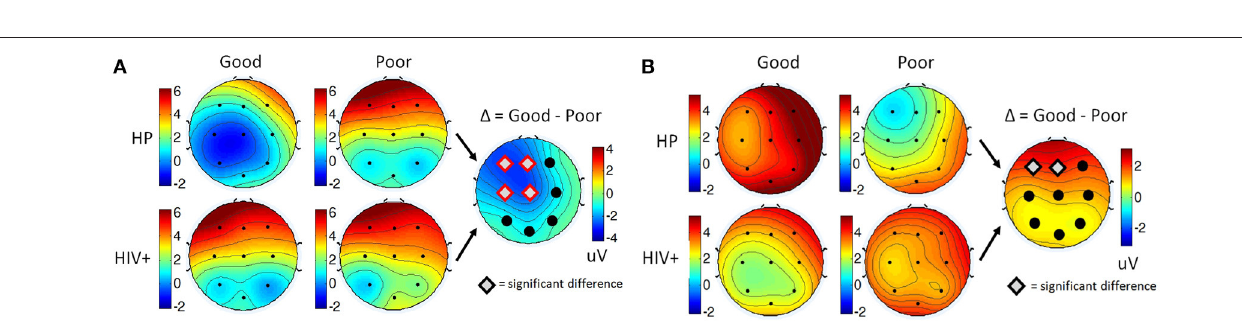
Frontiers in Human Neuroscience |